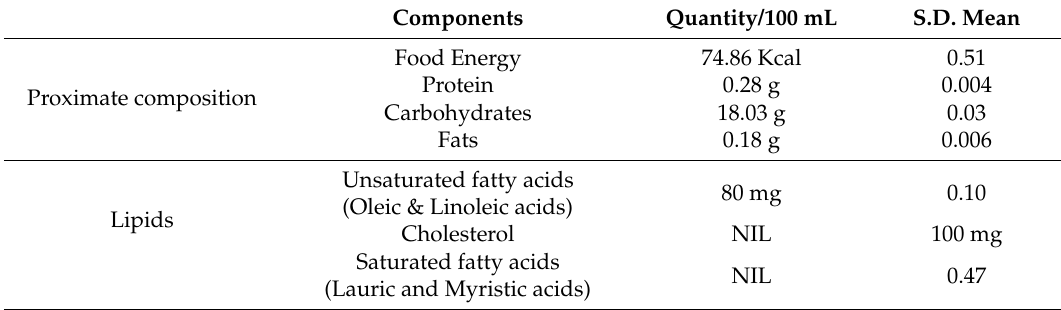
Table 2. The proximate composition and lipid profile of processed coconut Neera.